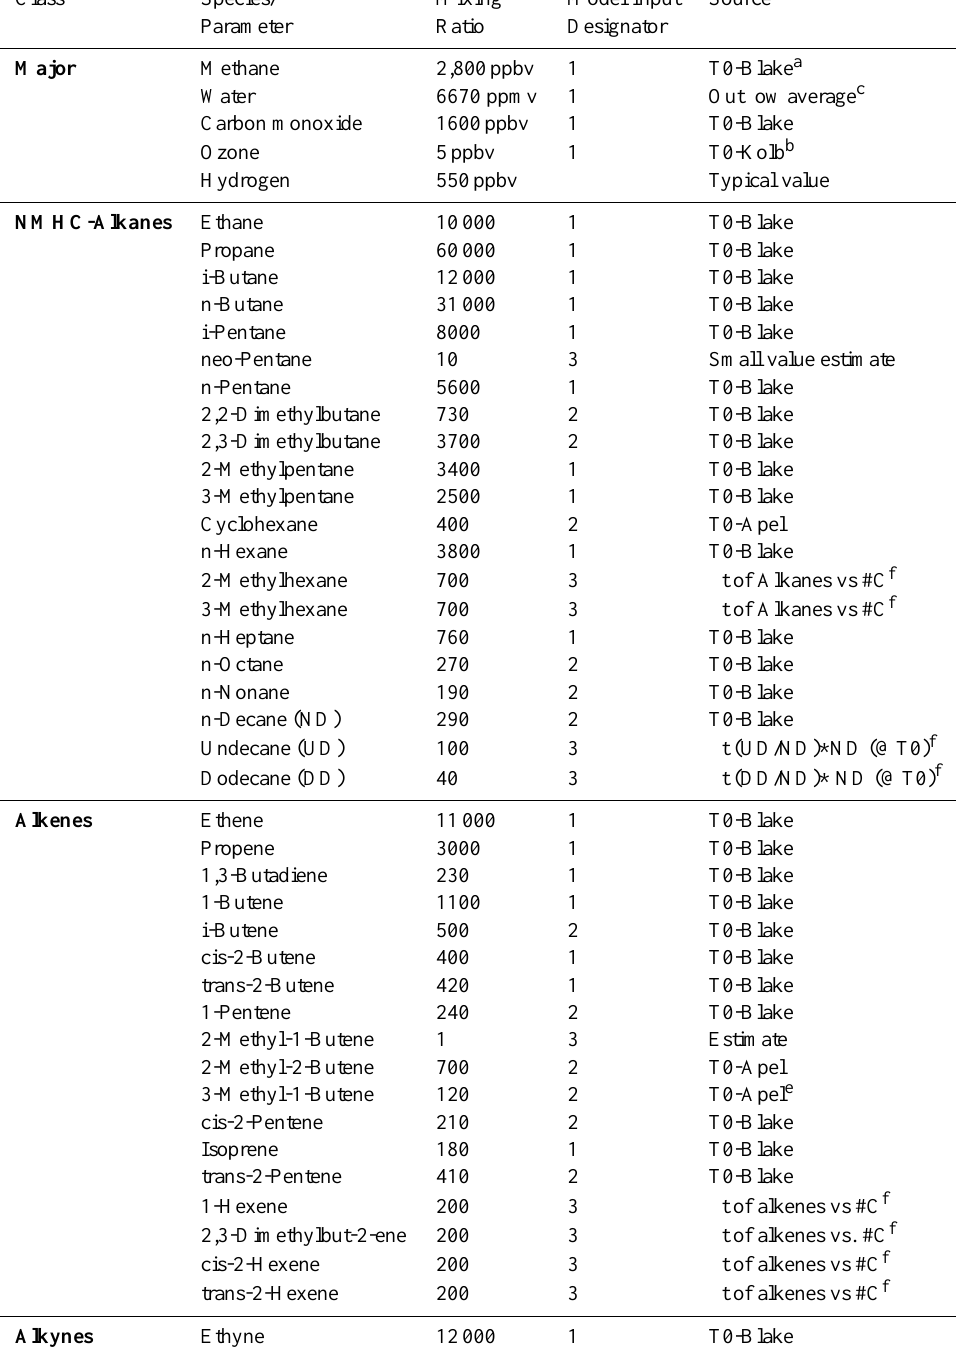
Table A3. Initial species mixing ratios (pptv unless otherwise indicated) used in MCM runs. The “Source” column indicates how these mixing ratios were determined. In the “Model Input Designator” column a 1 indicates that measurements were used and that the NASA Langley Box Model explicitly incorporates DC-8 measurements of that species as an input. MCM measurements were typically from 24- h median University of California Irvine (UCI) ground-based measurements at T 0 (see Apel et al., 2010) where available, or from aircraft measurements (C-130, DC-8 or their average). A 2 indicates the same MCM measurement source but the NASA Box Model did not explicitly incorporate that species as an input, and a 3 indicates an unmeasured species in both models whose mixing ratio was